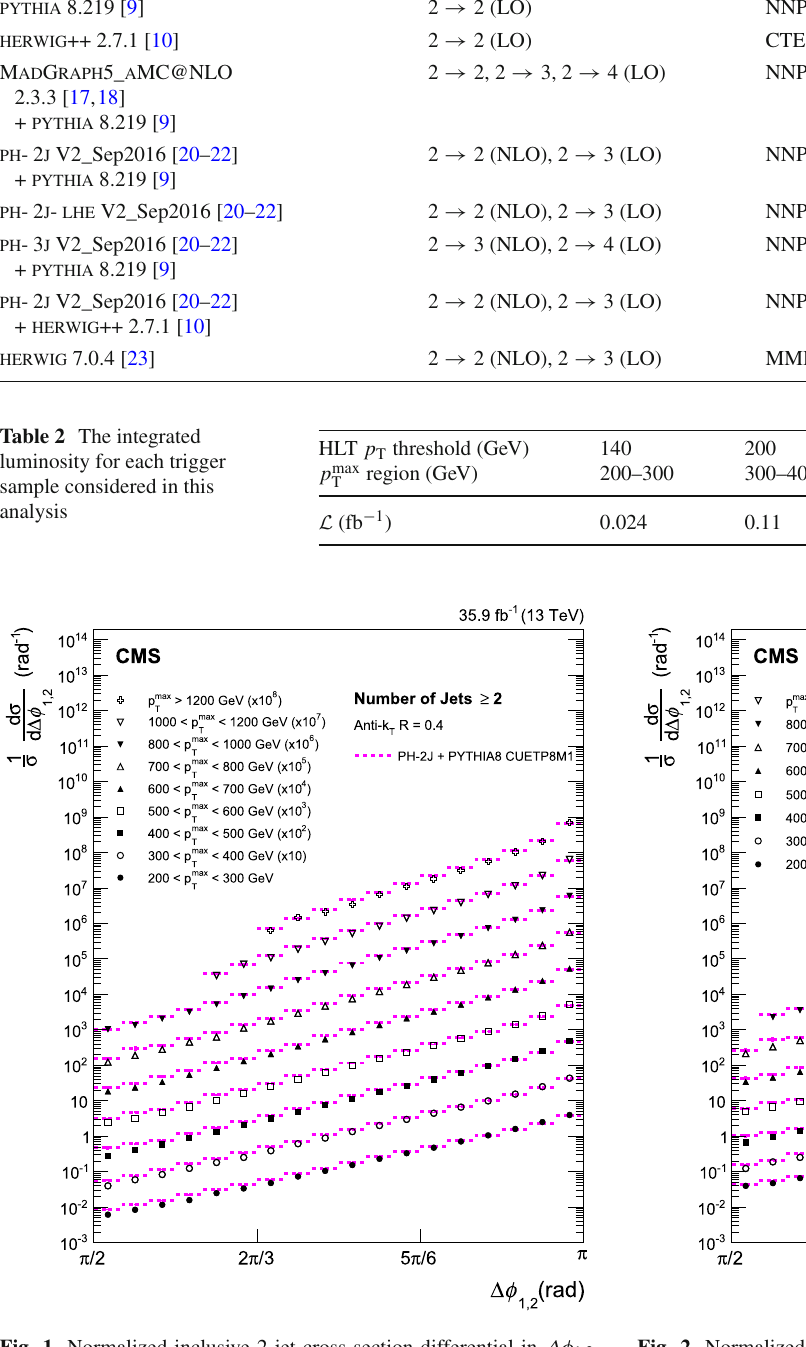
Fig. 2 Normalized inclusive 3-jet cross section differential in Δφ 1,2 for eight p max regions, scaled by multiplicative factors for presentation T purposes. The size of the data symbol includes both statistical and sys- tematic uncertainties. The data points are overlaid with the predictions from the ph- 2j + pythia 8 event